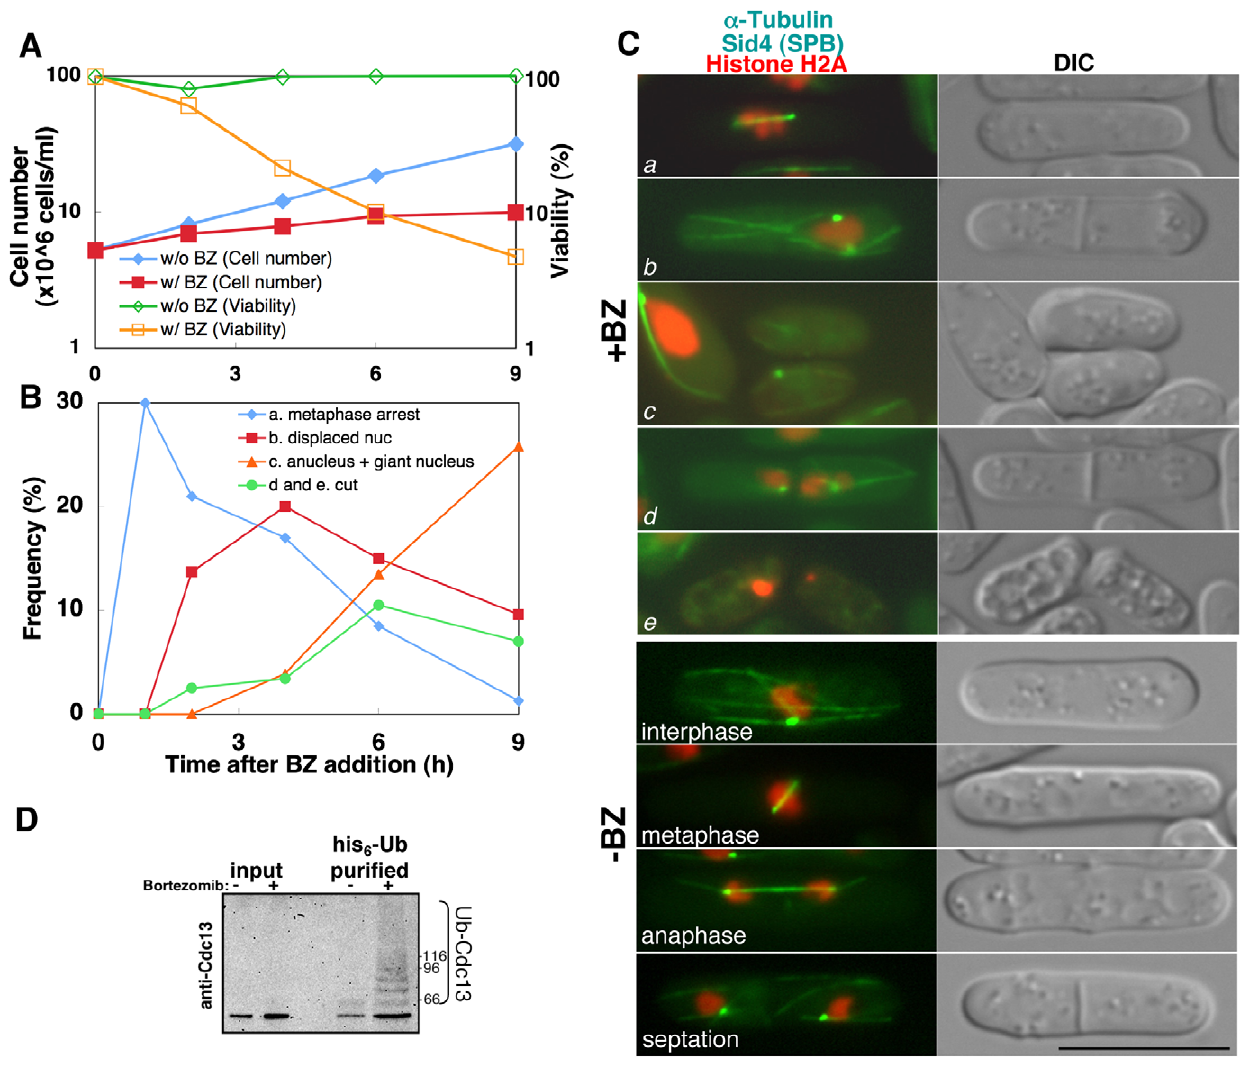
Figure 1. Bortezomib induces metaphase arrest. ( A ) Bortezomib (1 mM) inhibited cellular proliferation. Concentrations of cells and viabilities are presented. BZ: Bortezomib ( B ) Bortezomib (1 mM) inhibited the normal progression of the M phase. The graph indicates the ratio of cells with metaphase spindles and over-condensed chromosomes (blue, cells shown in Figure 1C- a ), cells with a displaced nucleus (red, Figure 1C- b ), cells without a nucleus and with a giant nucleus (orange, Figure 1C- c ), and cells with chromosome torn by the septum (green, Figure 1C- d , and e ). ( C ) Chromosomes, microtubules, and SPB were observed in the presence of Bortezomib. Cells showing mitotic abnormalities correspondent to Figure 2B are shown in a–e (upper panel: + BZ). Images of normal progression of cell division are shown in lower panel ( 2 BZ). Bar=10 m m ( D ) Poly- ubiquitinated cyclin/Cdc13 accumulated in the presence of Bortezomib. See text for details.